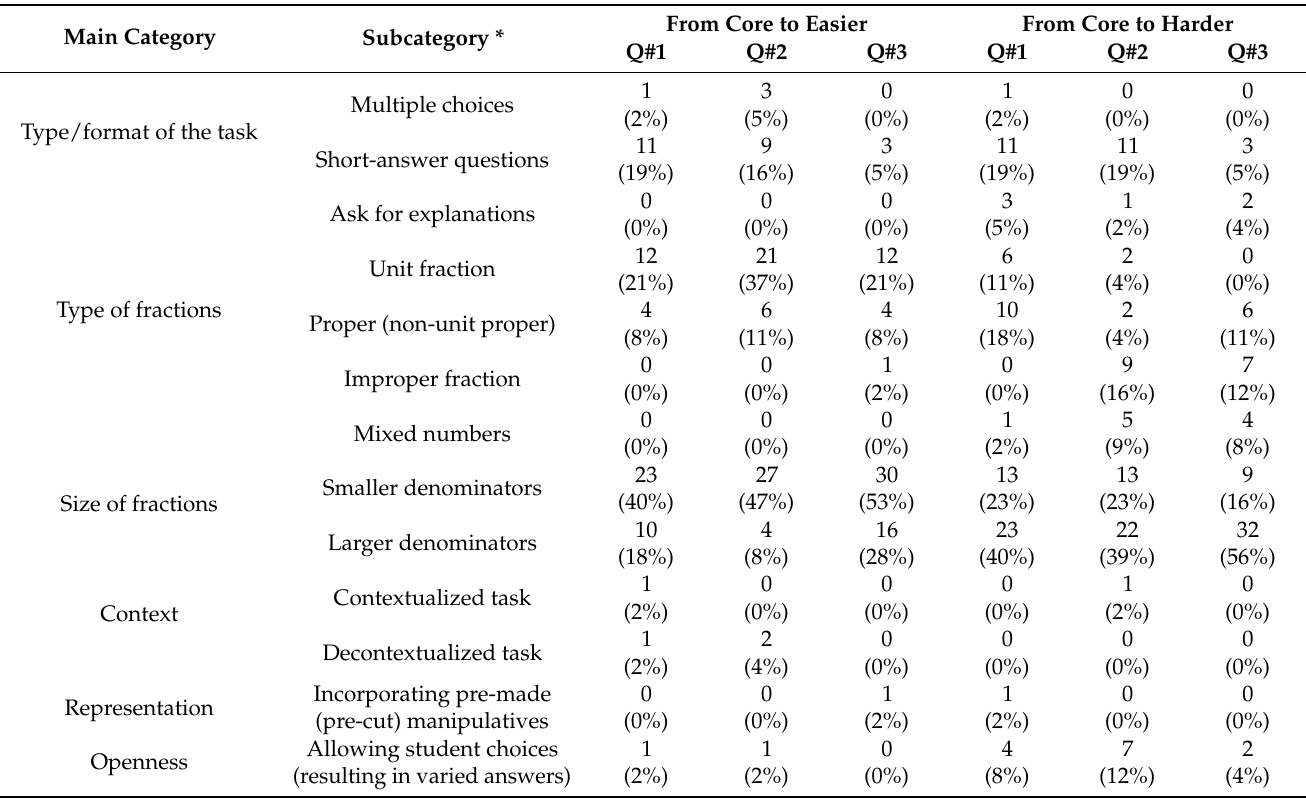
Table 5. Modification strategies in three question